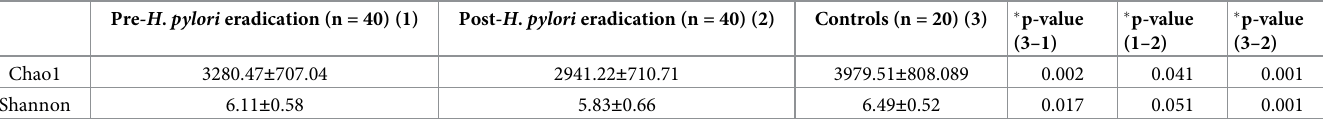
All values are means ± standard deviations. � P-value obtained for comparison of the richness and diversity index between different groups (1, 2,